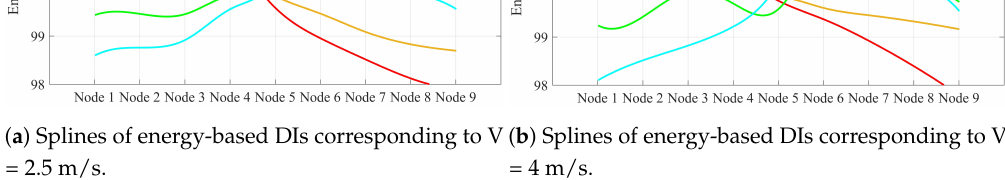
Figure 13. Splines of energy-based DIs along simply supported beam related to velocities ( a ) 2.5 m/s and ( b ) 4